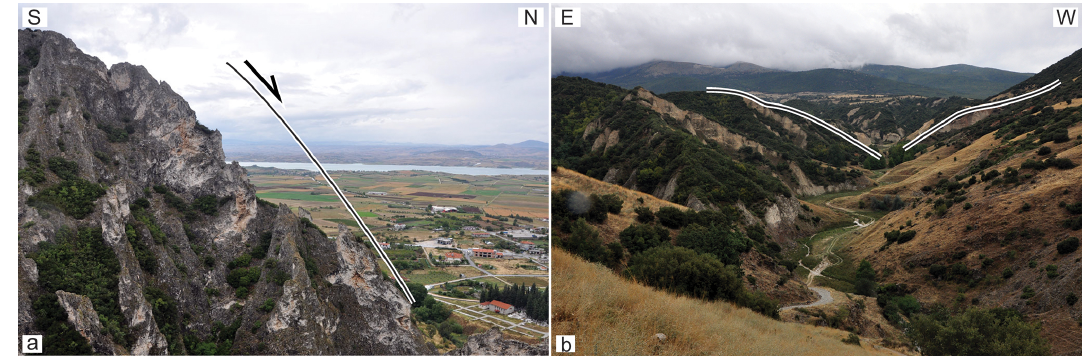
Figure 6. Topographic expression of the Servia fault, 10km SW of the working area (40 ◦ 10 (cid:48) 37 (cid:48)(cid:48) N, 21 ◦ 59 (cid:48) 50 (cid:48)(cid:48) E). (a) Erosion features on the fault scarp; on the horizon, the Kozani plain (ca. 280m above sea level) filled with Pliocene to recent lacustrine sediments found in the footwall at ca. 800m above sea level. (b) Concave-up hillslopes in valleys in the footwall of the Servia normal fault, suggesting fast recent